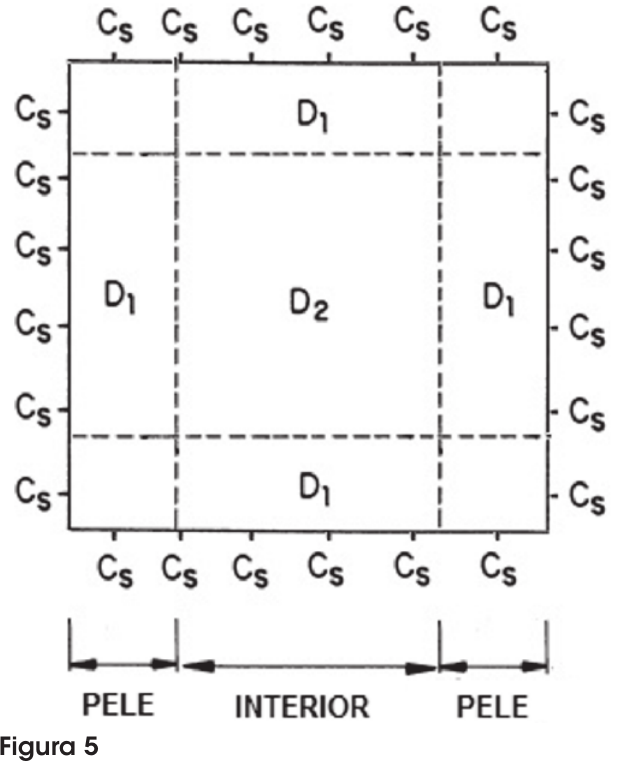
Figura 5 Efeito pele Fonte: adaptado de Andrade et al .